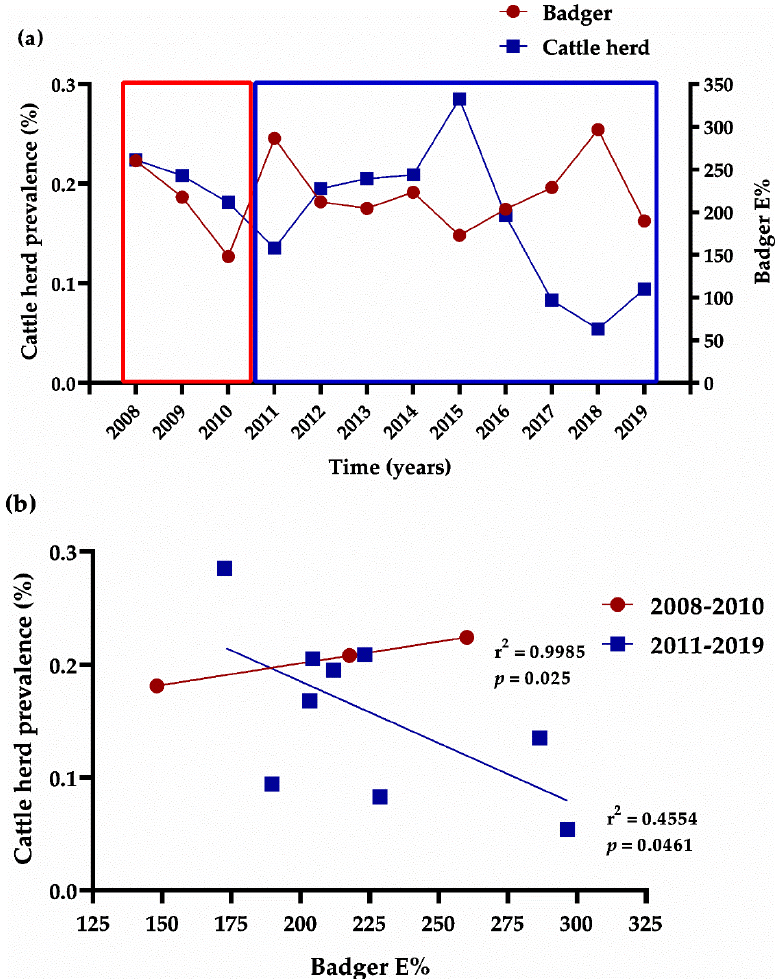
Figure 6. Correlation of tuberculosis (TB) prevalence in badgers and cattle herds in Asturias (At- lantic Spain). ( a ) Evolution of TB prevalence in badgers (red line) and cattle (blue line) by year. Prevalence in badgers was based on mean E% in the P22 ELISA. ( b ) Correlation between TB prev- alence in cattle herds and mean E% in the P22 ELISA in badgers.